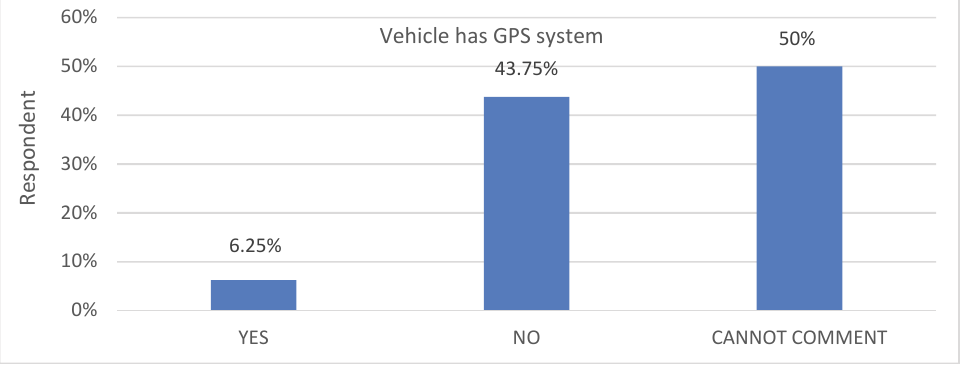
Fig. 6. GPS system in BMW